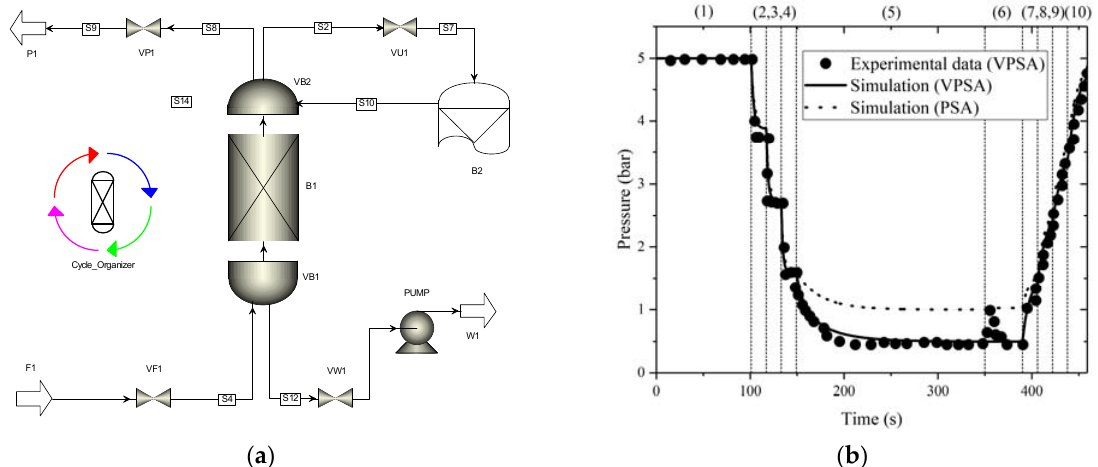
Figure 3. VPSA flow diagram ( a ) and pressure curves ( b ). Symbols: Experimental data for VPSA from [35]. Lines: Simulation results of VPSA (—) and PSA (- - -).